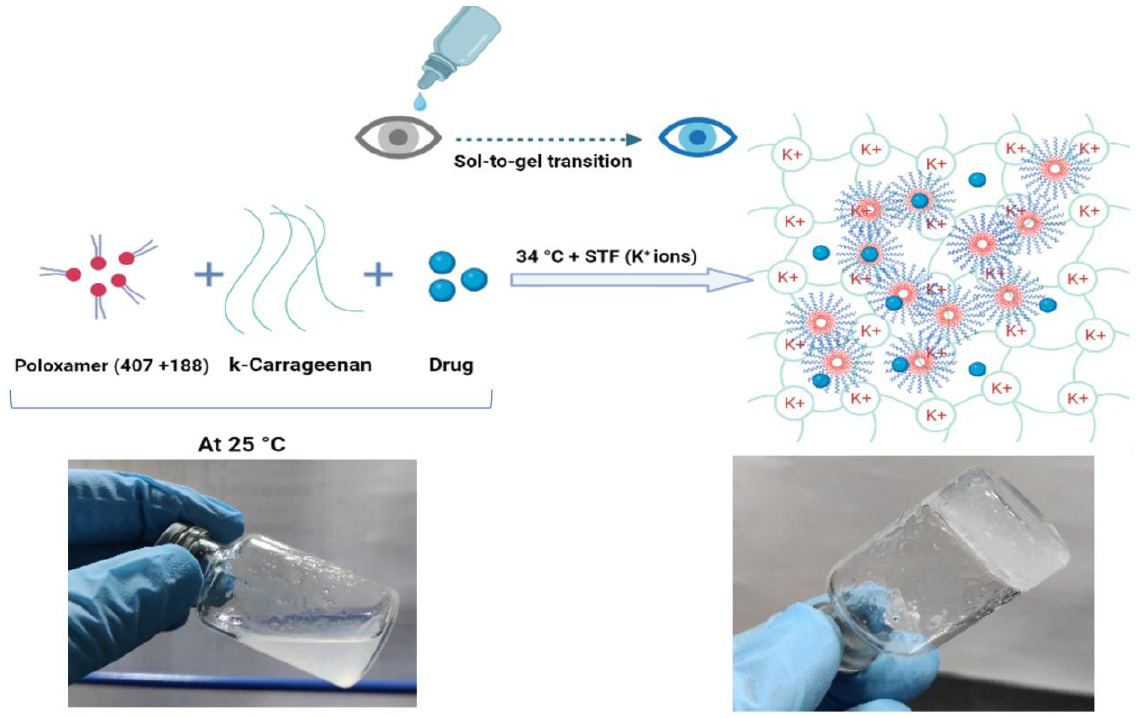
Figure 1. Illustration showing the possible gel matrix formed by the NEB-loaded dual-responsive in situ gel at 34 °C in presence of STF (containing K + ions).